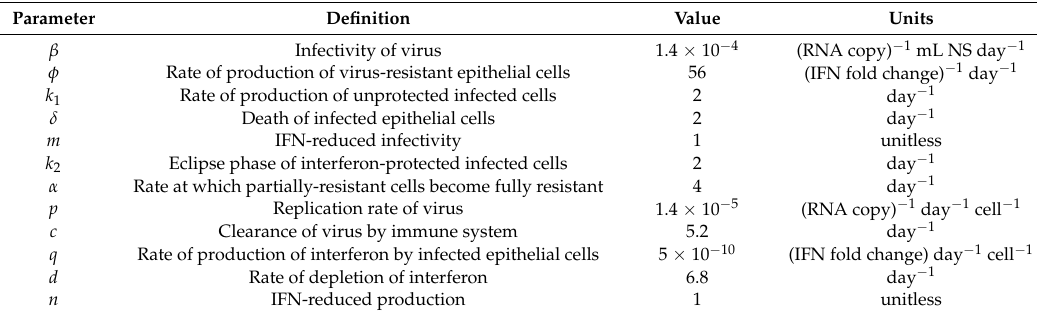
Table A2. Parameter definitions and values for the Saenz model.